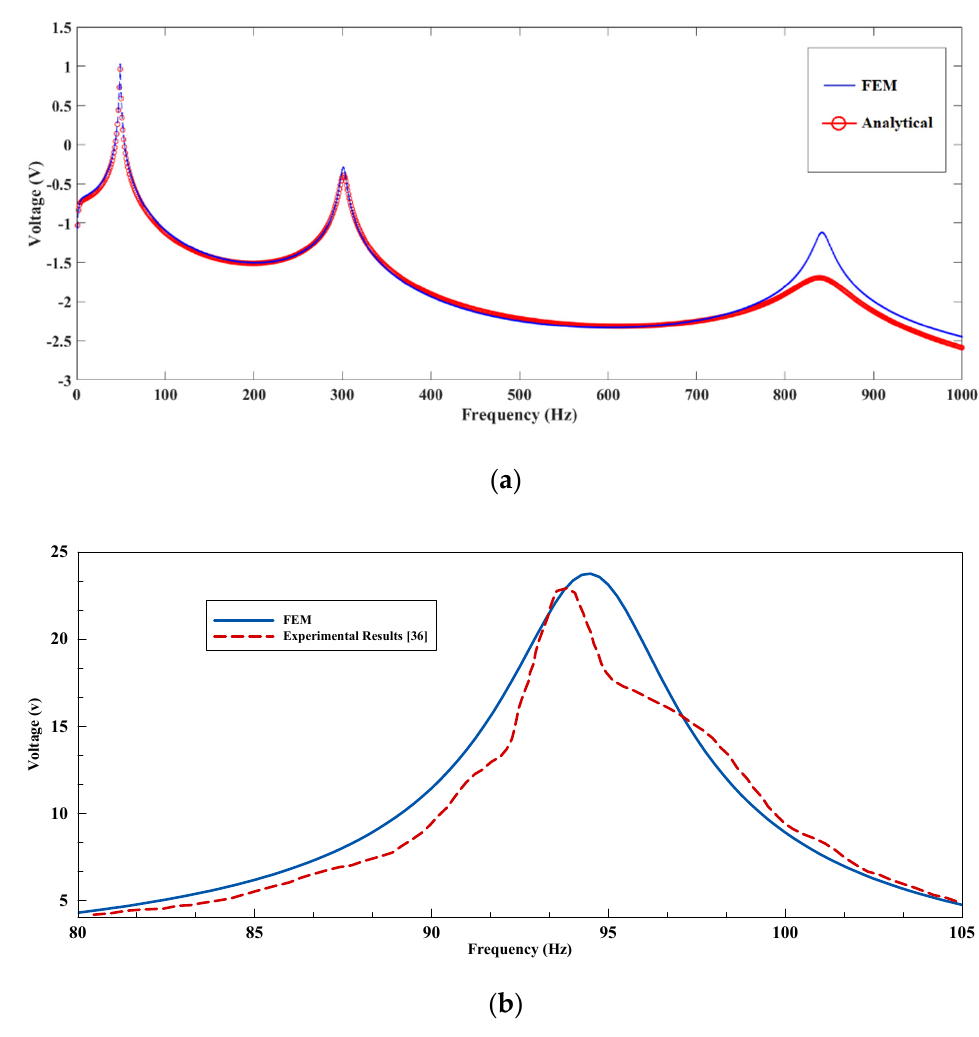
Figure 7. The comparison of the COMSOL Multiphysics simulation results ( a ) in logarithmic scale with the analytical results (Equation (35)) within the range of 0 to 1000 Hz for R l = 10 6 Ω and ( b ) with the experimental results reported by Pradeesh and Udhayakumar within the range of 80 to 105 Hz [36].